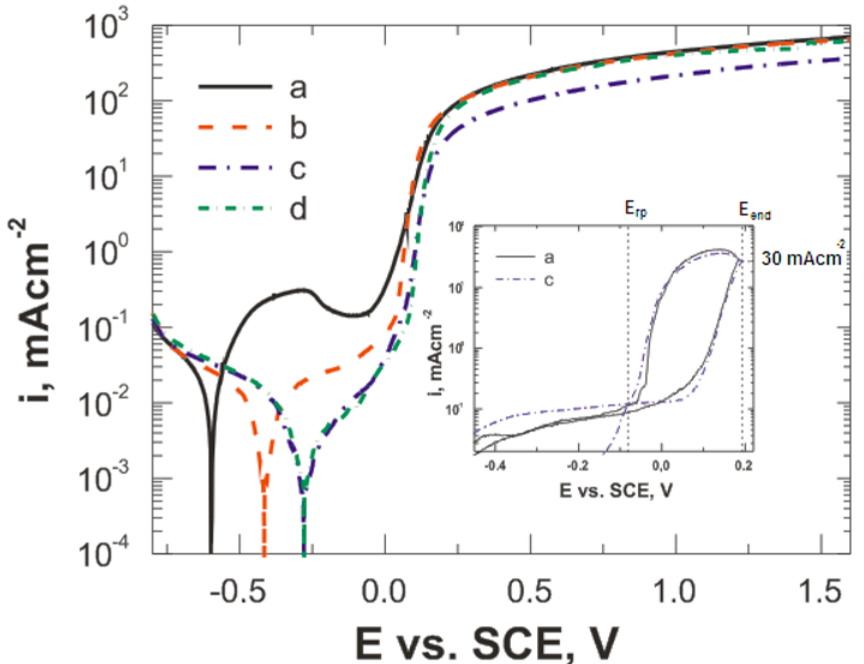
Figure 11. Potentiodynamic curves (a) for bare stainless steel, and for stainless steel samples covered with (b) 4-ABA/K (c, d) 4-ABA film in electrochemical deposition process by using (b, c) cyclic voltammetry and (d) chronopotentiometry. Scan rate, 10 mV s -1 . Inset: model repassivation curves. Electrolyte 0.25 mol dm -3 K